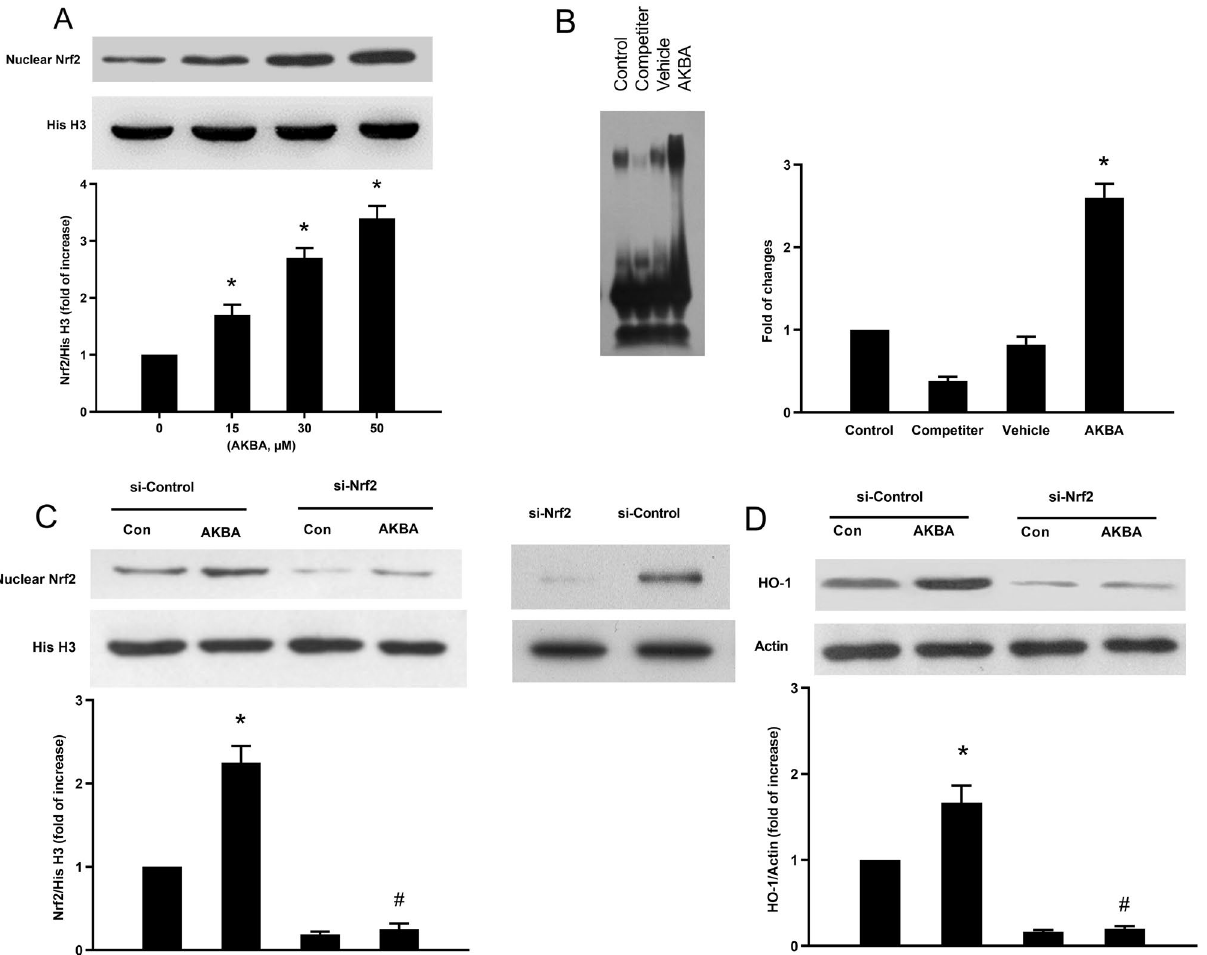
Figure 5. AKBA induces expression of Nrf2 and Nrf2-binding activity in primary cultured neurons. All data represent the mean ± SD of triplicate independent experiments. ( A ) AKBA induced Nrf2 expression in a concentration-dependent manner. *P < 0.05 vs control ( B ) After 2 hour treatment with vehicle or 50 μM AKBA, nuclear extracts were prepared and were used to analyze Nrf2 bingding activity by EMSA. ( C ) Cells were transiently transfected with control or Nrf2 siRNA for 48 h (transfection efficiency was checked by Western analysis), followed by treatment with 50 μM of AKBA for an additional 8 h. Nuclear extracts were analyzed for Nrf2 levels. ( D ) Representative immunoblots for HO-1 following 50 μM of AKBA treatment for 24 h in control and Nrf2 siRNA-treated cells. *P < 0.05 vs si-control group without AKBA and # P < 0.05 vs si-control group with